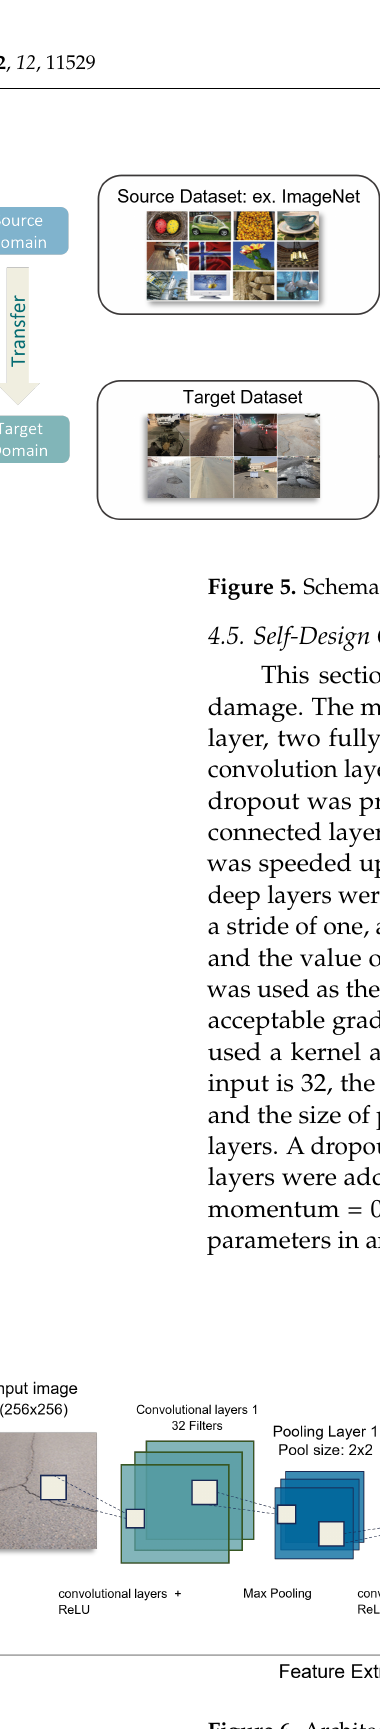
Figure 6. Architecture of